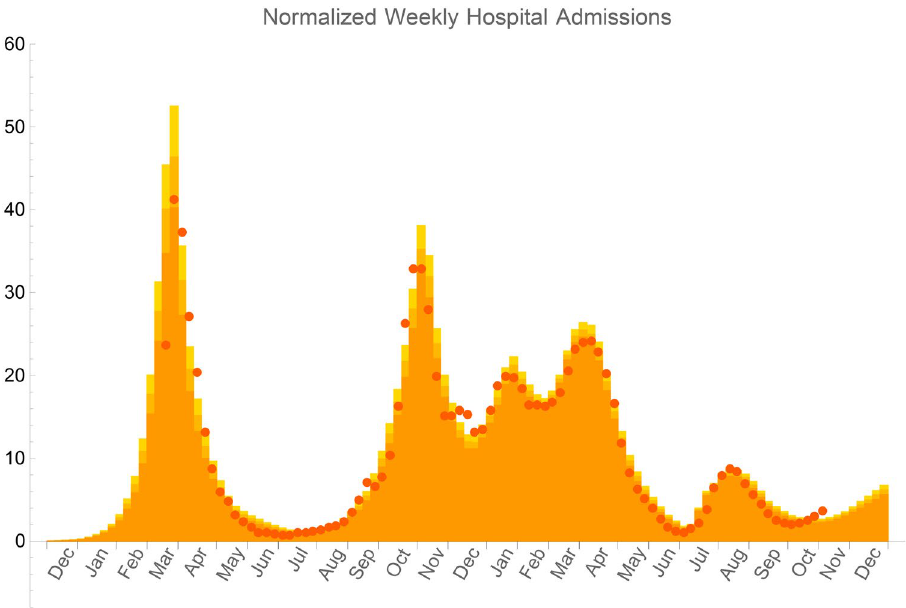
Figure 2. Number of weekly hospital admissions normalized to 50,000 households. Orange bars correspond to PERCOVID model prediction averaged over ten simulations and red points to the epidemiological data from Santé Publique France 18 . Statistical errors at 95% CL are represented by slightly different orange